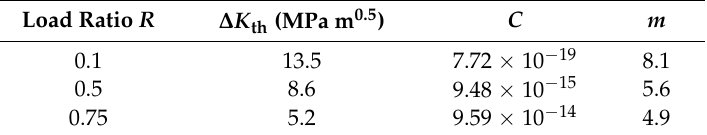
Figure 6. Fatigue crack growth curves plotted as a function of the nominal stress intensity factor range. Table 5. Best-fit parameters of the crack propagation law expressed by Equation (3).